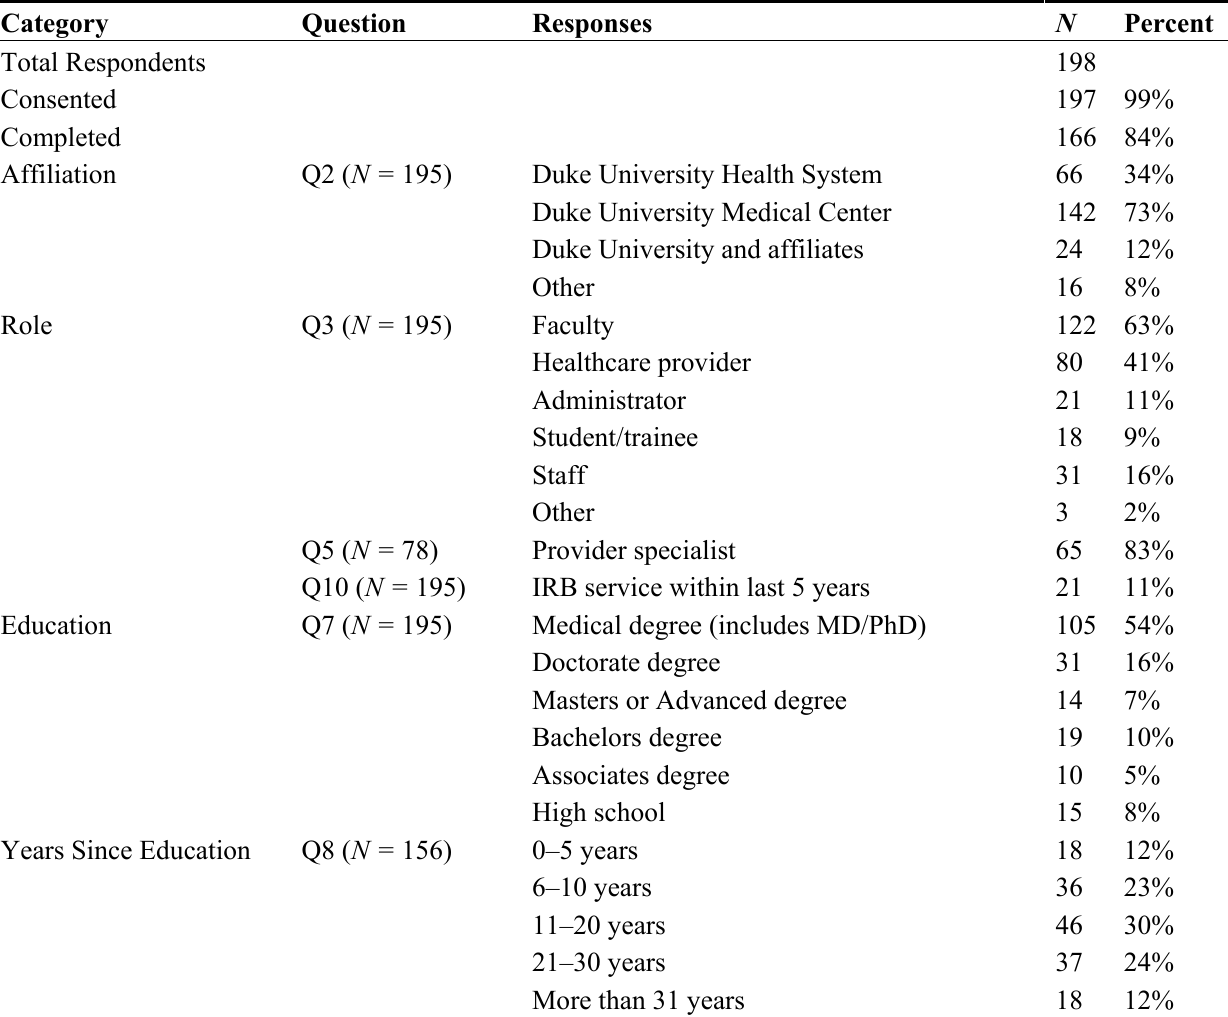
Table 3. Characteristics of